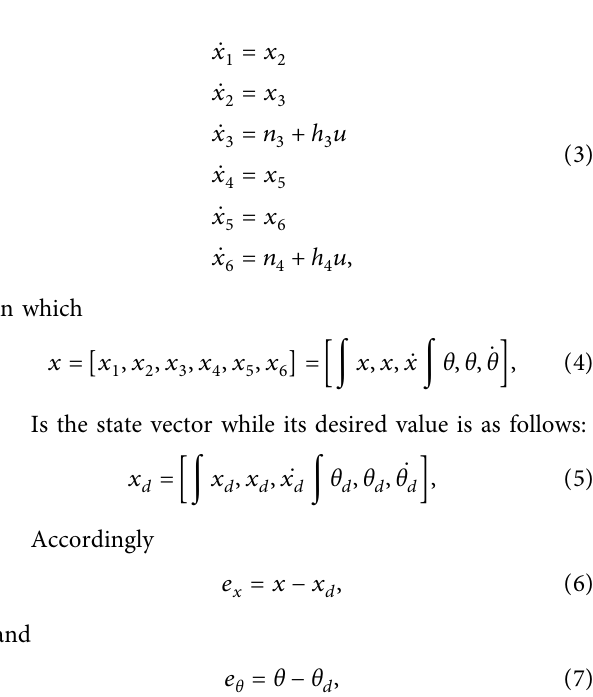
Figure 1: Configuration of the considered